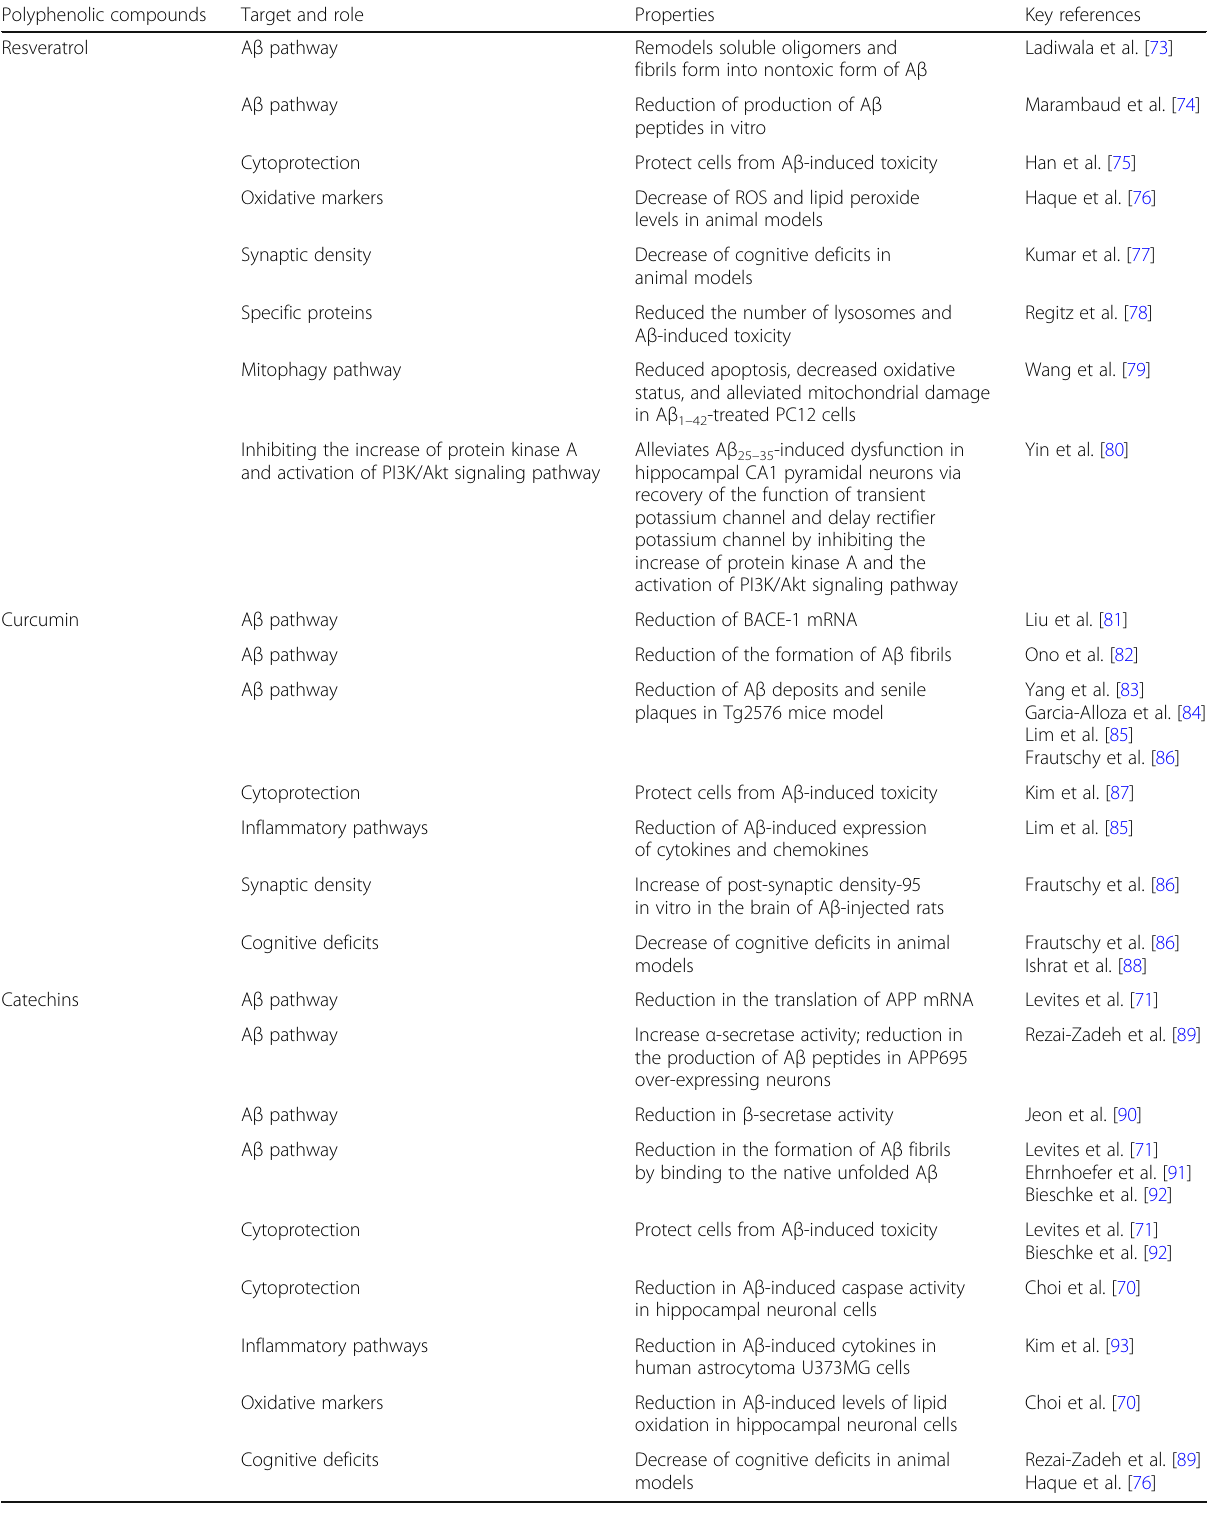
Table 1 The beneficial role of selected polyphenolic compounds in Alzheimer ’ s disease Polyphenolic